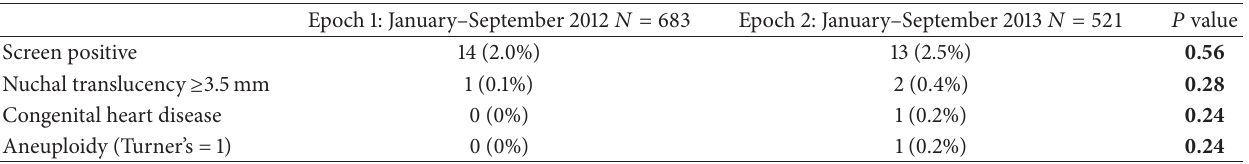
Table 2: Nuchal translucency screen positive results and outcomes: 2012 verses